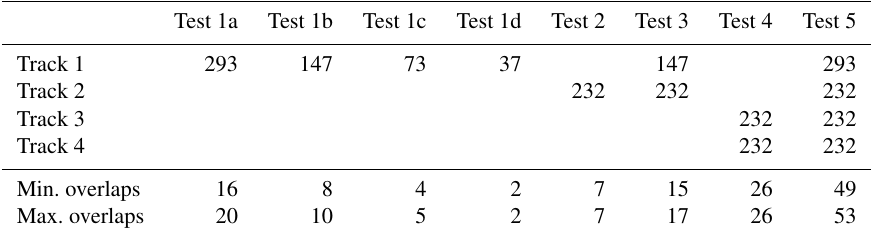
Figure 4. Study reach of the Meuse River with GCPs, RTK GPS measurements with cross-section locations and numbers, and some image footprints for all UAV tracks. Table 1. Number of photographs and overlaps for the